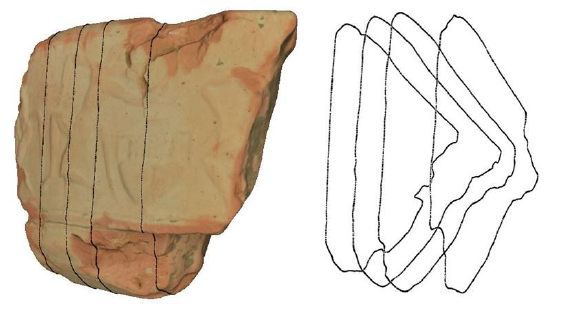
Figure 19. Digital cross sections of the Komòs